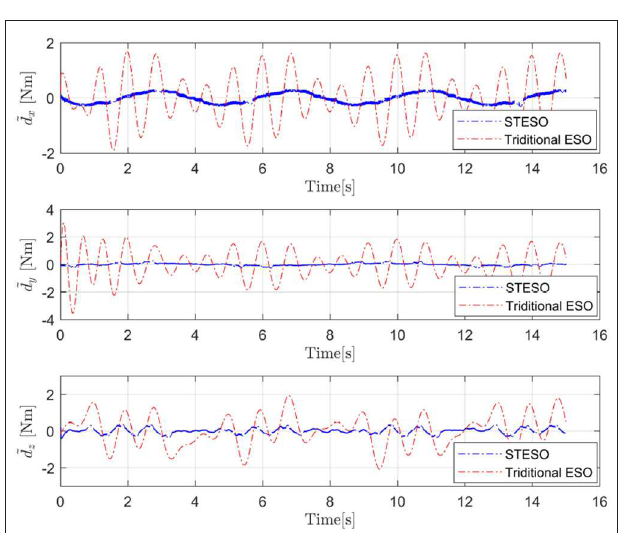
FIGURE 7 | Disturbances estimate errors ( ˜ d x , ˜ d y , ˜ d z ) of the STESO and traditional